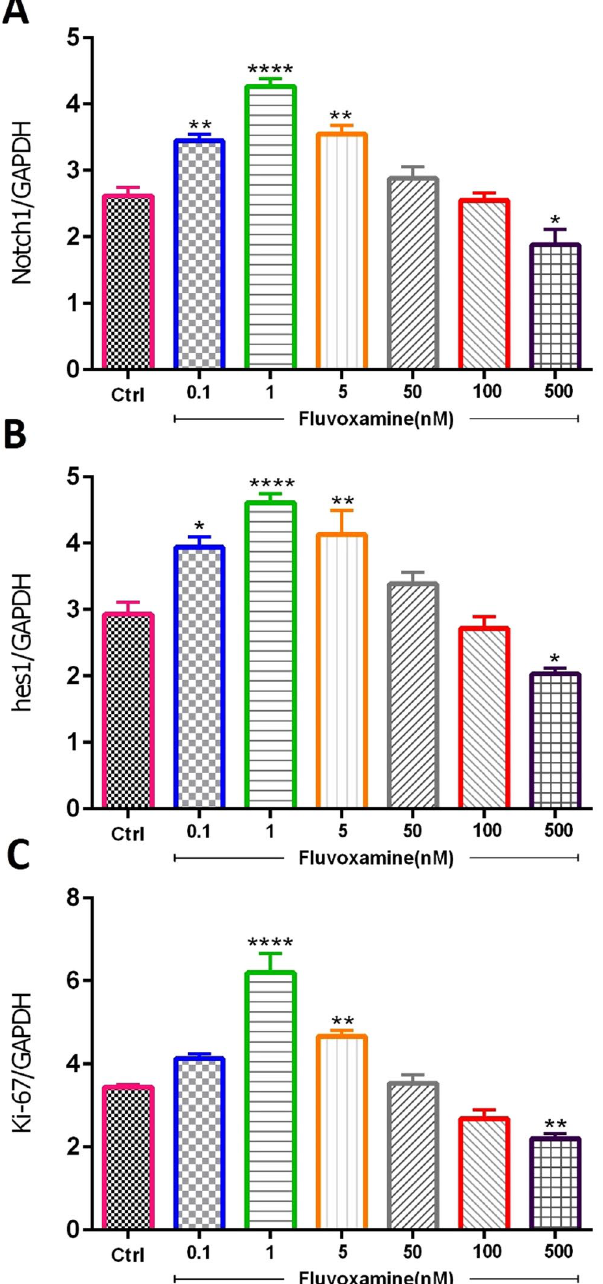
Figure 2. Effect of fluvoxamine on mRNA expression levels of Notch1, Hes1 and Ki-67 transcription factors. ENSCs were cultured with 0.1, 1, 5, 50, 100 or 500 nM concentrations of fluvoxamine for 5 days. Total RNA was prepared from each culture, cDNA synthesized and subjected to real-time PCR, using specific primers for Hes1, Notch1 or ki-67. GAPDH was used as an internal control. Each experiment included 5 replicates per condition (n = 5). The values are expressed as the mean ±